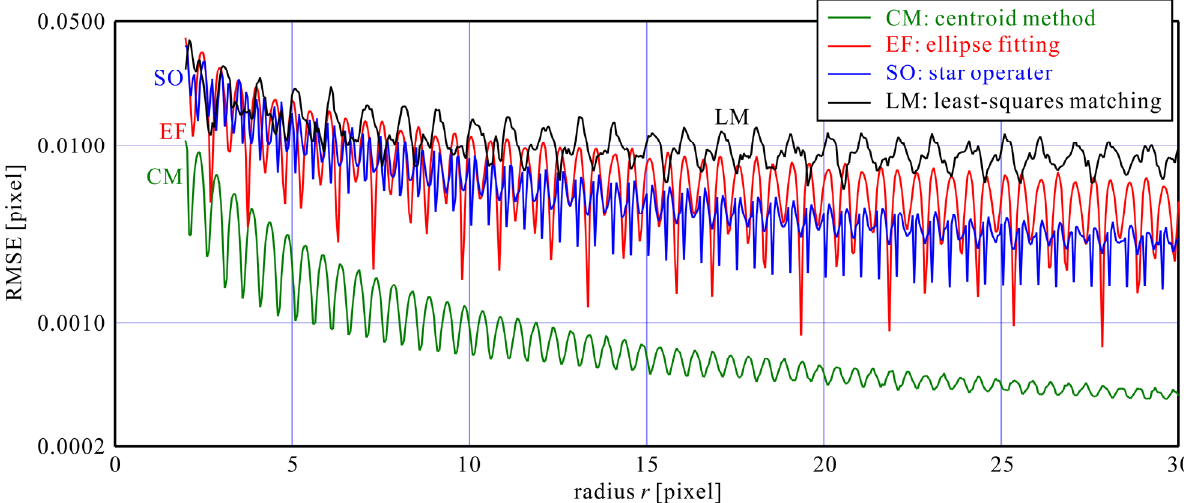
Figure 3. RMSE of the center location measurement of a circle (2 pixels  r  30 pixels)